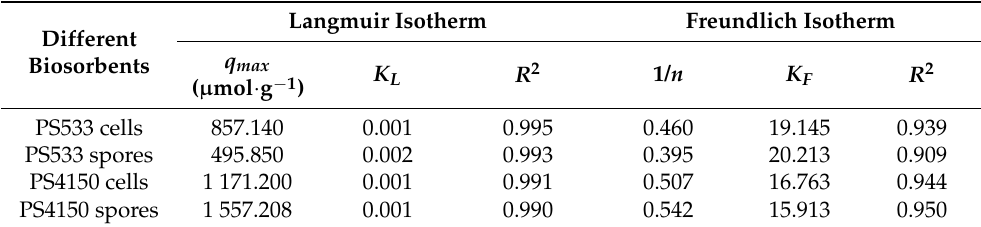
Table 2. Adsorption isotherm model parameters of Tb(III) by B. subtilis